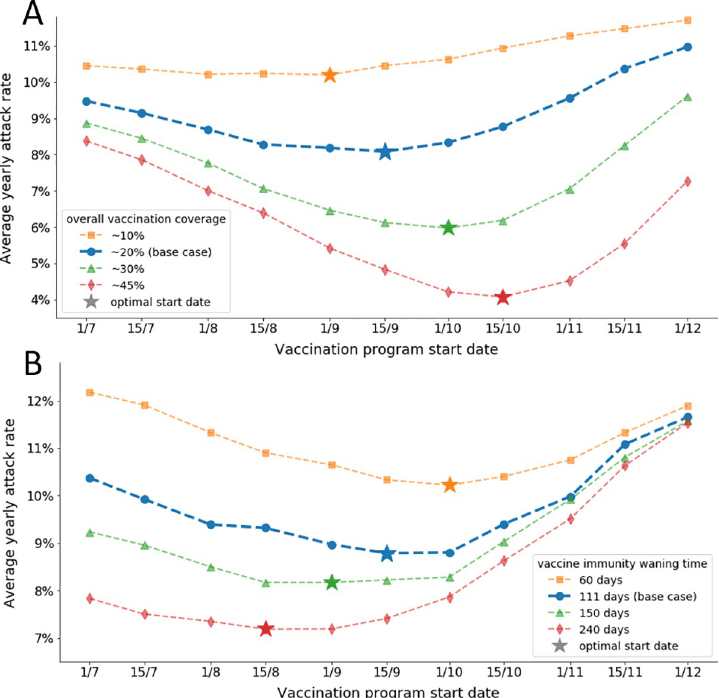
Fig 4. Optimization of the vaccination program start date. Model predictions of the average yearly attack rate over seven seasons for each possible program start date. The star on each line represents the optimal start date for the corresponding line. (A) Optimization for different levels of vaccination coverage. Each line represents a different overall vaccination coverage level, where the bold blue line represents the base case of Israel, i.e., ~20% overall vaccination coverage. (B) Optimization for different values of vaccine-induced immunity waning time, where the bold blue line represents the base case, with a waning time of 111 days.